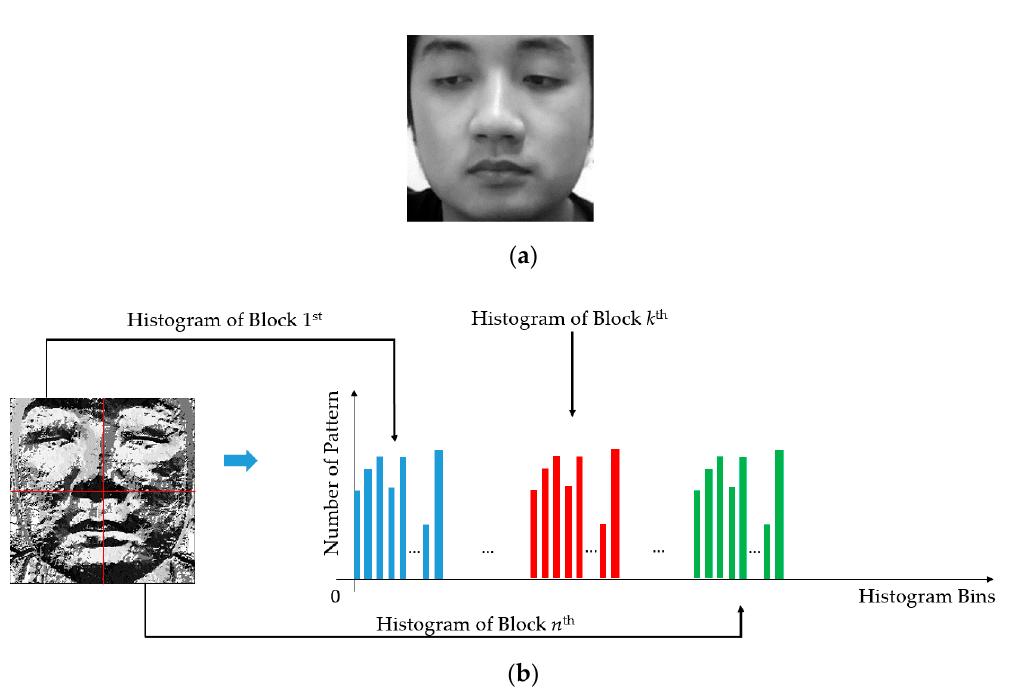
Figure 5. Handcrafted image feature extraction process using the MLBP method: ( a ) an input face image from NUAA dataset [16]; ( b ) formation of the MLBP features of (a) (left: encoded LBP image; right: LBP